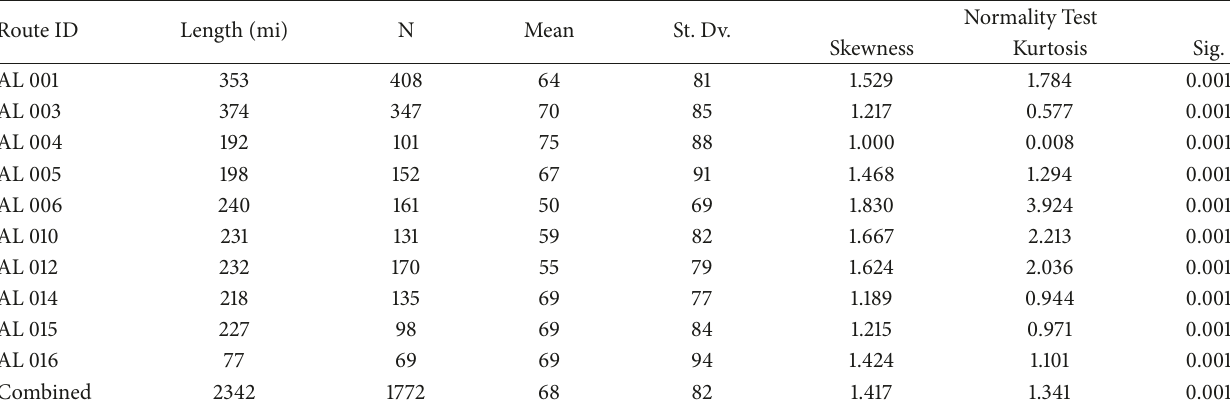
Table 2: Descriptive statistics of the nonsevere wet-weather crash rates and tests of normality for the ten selected routes. Route ID